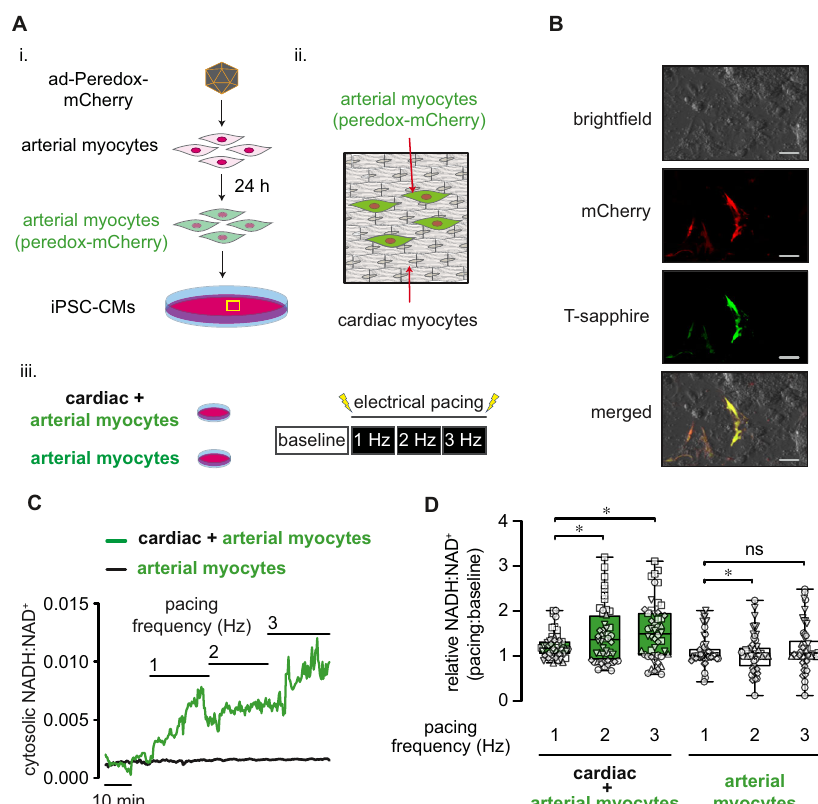
Fig. 2 Arterial myocyte NADH:NAD + is sensitive to changes in proximal cardiomyocyte beating frequency. A Schematic illustration depicting the preparation of arterial myocyte/induced pluripotent stem cell-derived cardiomyocyte (iPSC-CM) co-cultures. Primary aortic vascular smooth muscle cells (passage 0 – 2) were treated with adenovirus to express the NADH:NAD + -sensitive fl uorescent biosensor peredox-mCherry (i.). Arterial myocytes were then seeded and allowed to integrate (48 h) onto a two-dimensional monolayer of iPSC-CMs (ii.). Imaging was performed on either arterial/cardiac co- cultured myocytes or arterial myocytes alone during electrical stimulation (1 – 3 Hz; iii.) while monitoring peredox-mCherry green:red fl uorescence. B Exemplary bright fi eld and fl uorescence images showing red (mCherry) and green (T-sapphire) fl uorescence of peredox-mCherry expressing arterial myocytes in the presence of non- fl uorescent cardiac myocytes in an arterial + cardiac myocyte co-culture. Scale bars represent 100 μ m. Experiment was repeated six times with similar results. C Exemplary time series of arterial myocyte NADH:NAD + in either an arterial/cardiac myocyte co-culture (green trace) or arterial myocytes alone ( – cardiac myocytes; black trace) at baseline (0 Hz) and during electrical stimulation (1 – 3 Hz). D Box and whiskers plots (line: median, box: 25th to 75th percentile, whiskers: min and max) summarizing fold-change in NADH:NAD + in arterial myocytes in arterial/cardiac myocyte co-cultures or arterial myocytes alone. Α rterial/cardiac myocytes, n = 50 cells from 5 independent experiments, 2 vs. 1 Hz, * p = 0.0047; 3 vs. 1 Hz, * p = 0.0012; Arterial myocytes only, n = 52 cells from 6 independent experiments, 2 vs. 1 Hz, * p = 0.0029; 3 vs. 1 Hz, ns: p = 0.6574 (Linear mixed models, log-transformed NADH:NAD + ). Source data are provided as a Source Data fi